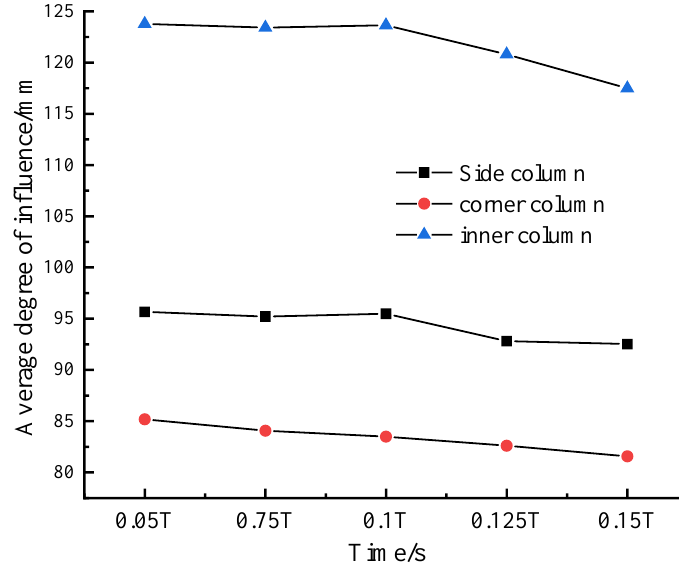
Figure 9. Element failure time.